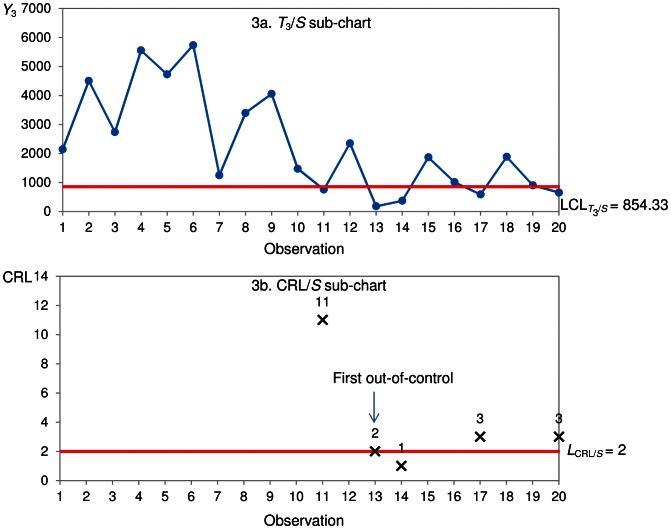
Synth-T
3 chart.